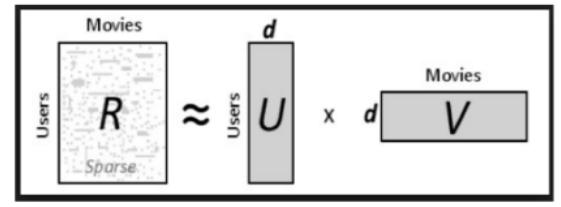
Figure 1. The Matrix Factorization